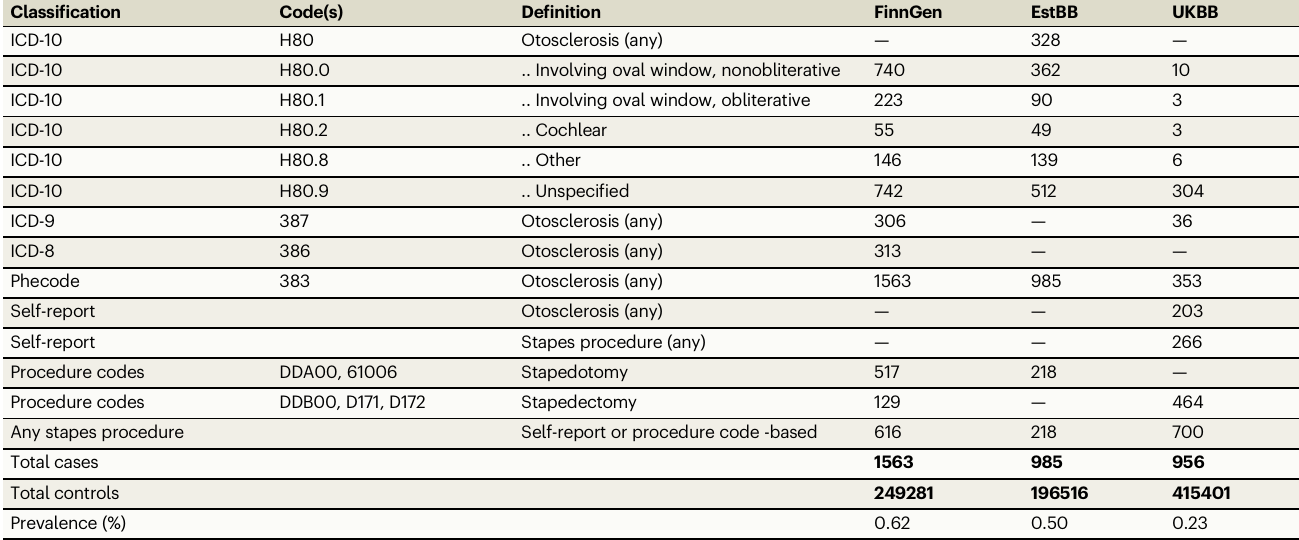
Table 1 | Identi fi cation of otosclerosis cases in the study cohorts based on ICD codes, procedure codes and self-reported data